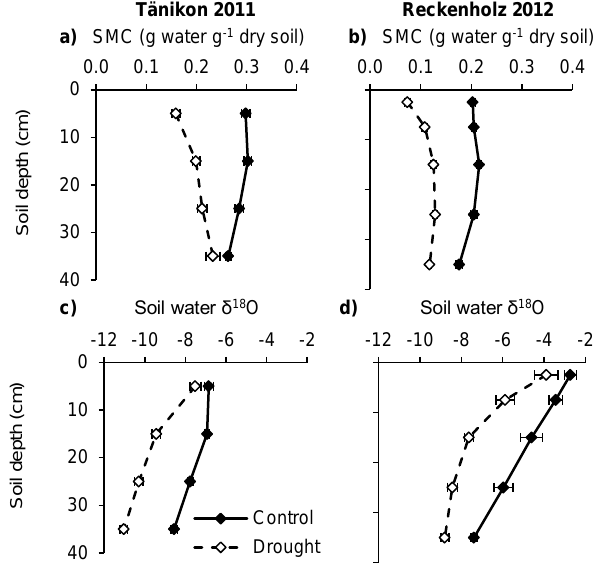
Figure 1. Mean ( ± SE) soil moisture content (SMC, g water g dry soil − 1 ) (a, b) and δ 18 O value of the soil water extracts (c, d) throughout the soil profile for control and drought plots averaged across the different communities in Tänikon (2011) and Reckenholz (2012) ( n = 10).